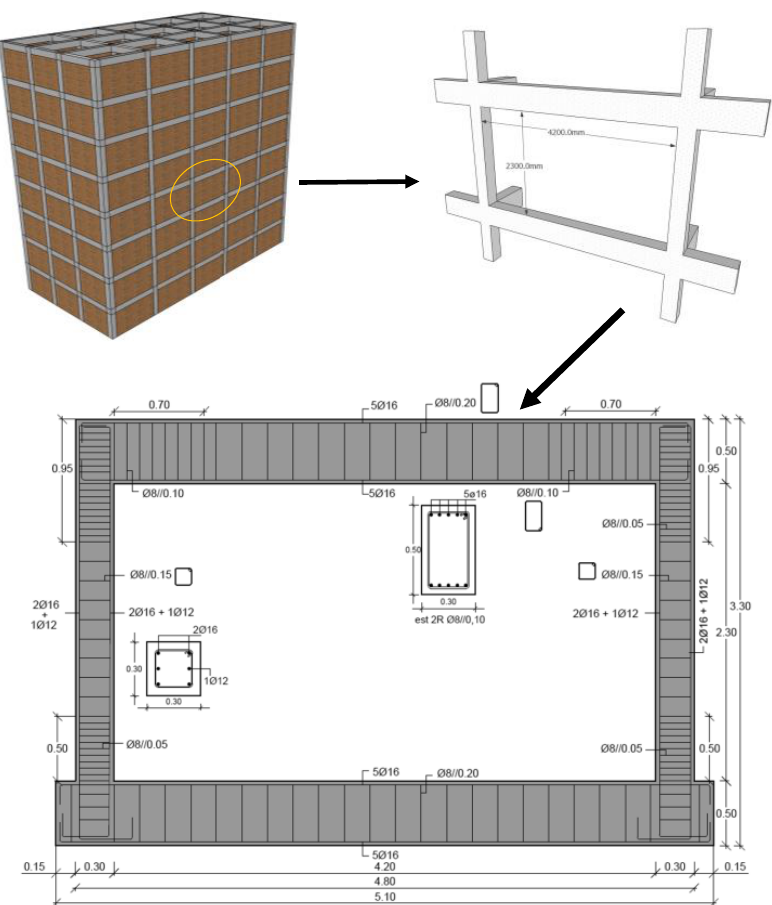
Figure 3. Prototype specimen: geometric dimensions of the frame selected and reinforcement de- tailing.